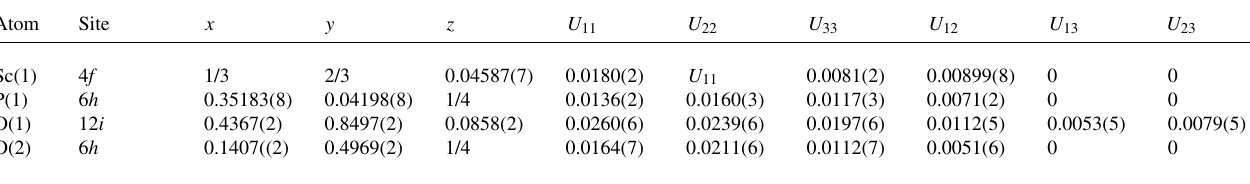
Table 3. Atomic coordinates and displacement parameters (in Å 2 ) .